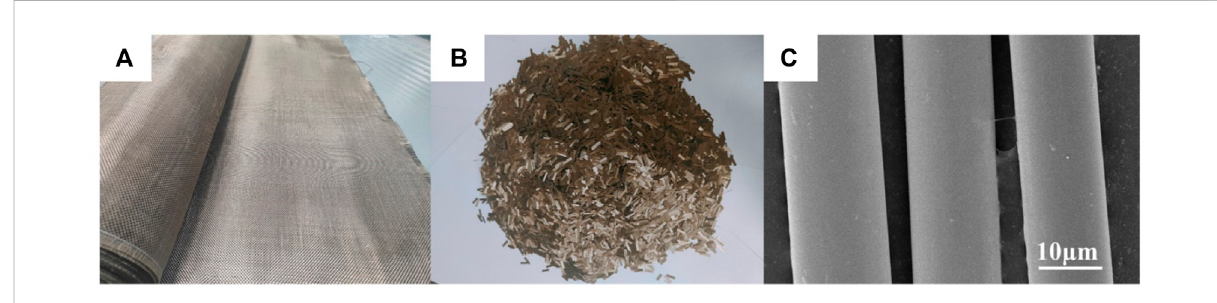
Basalt fi ber ’ s physical appearance, (A) sheet, (B) short fi bers, and (C) SEM image of basalt fi ber (Liu H. et al.,